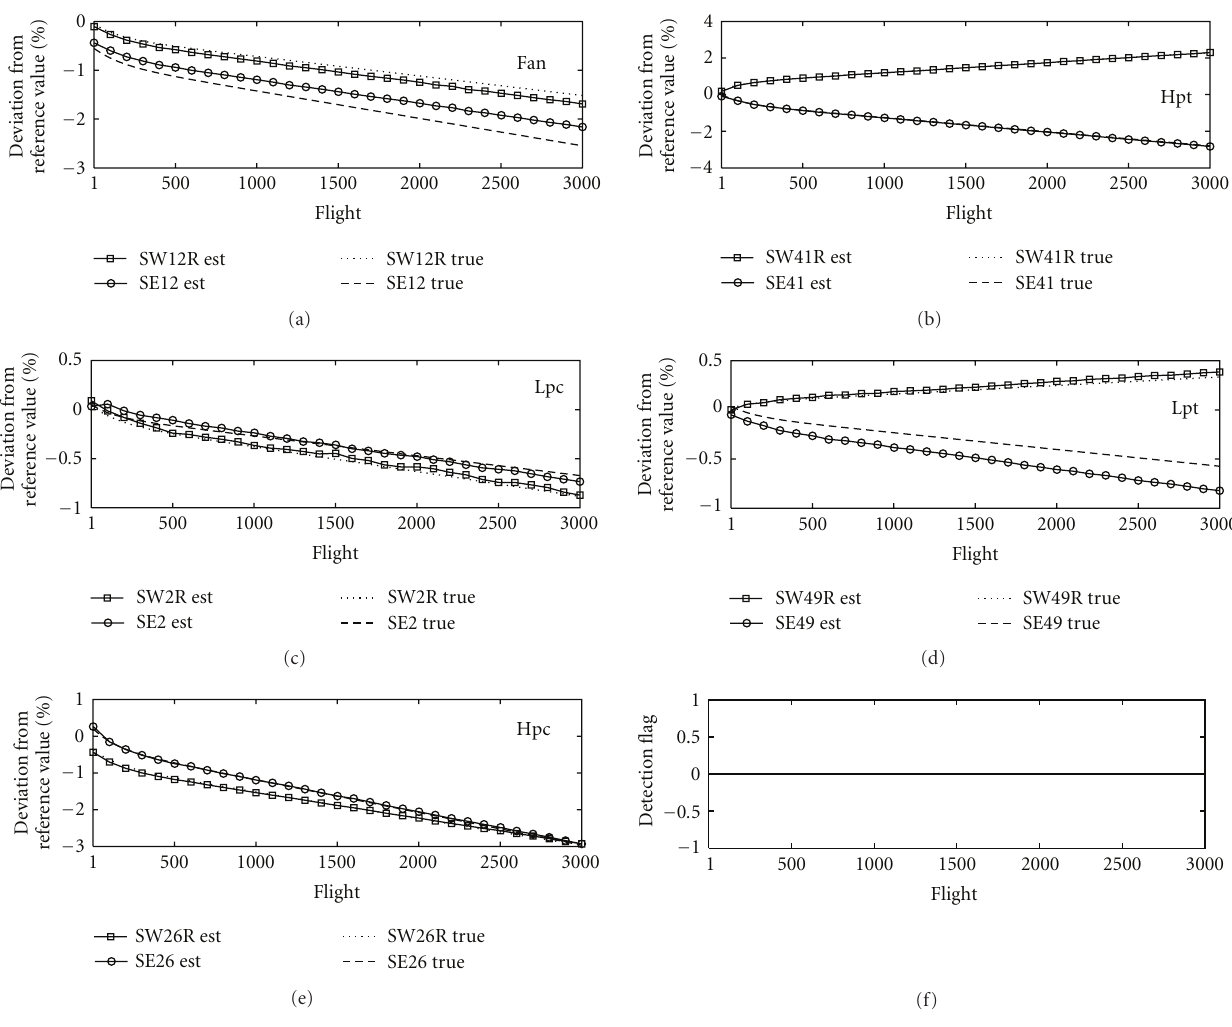
Figure 5: Tracking of engine wear with the adaptive diagnosis tool—in the legends, “est” stands for estimated.